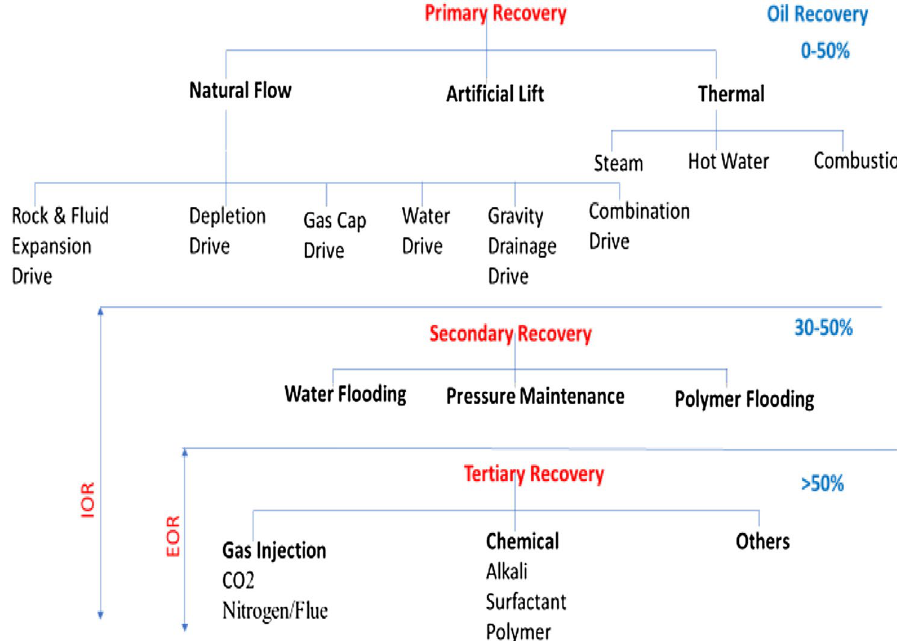
Fig. 1 Enhanced oil recovery/ improved oil recovery